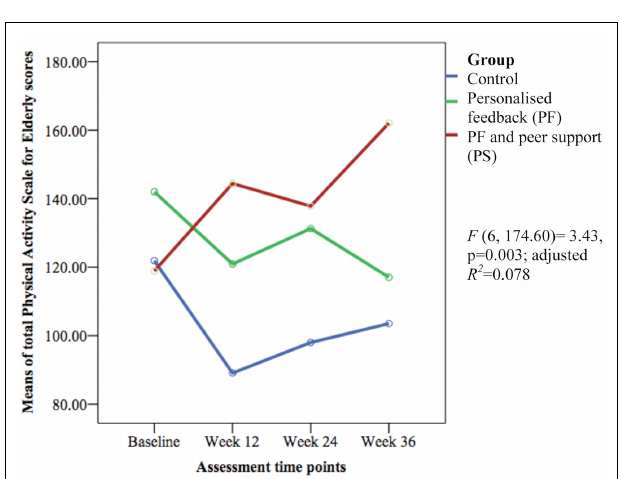
FIGURE 3 | Mean differences on weekly duration of structured physical activity between groups over time .